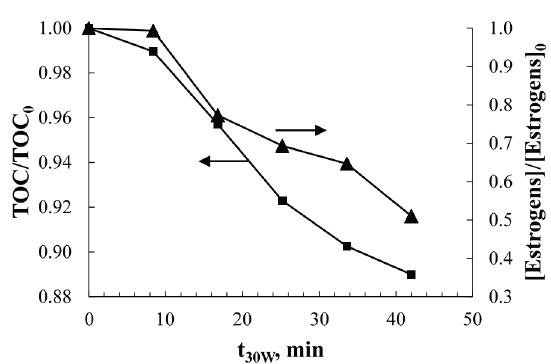
Figure 2. Solar photolytic degradation ( right axis ) and mineralization ( left axis ) of the commercial formulation of E2 and nomegestrol acetate mixture with an initial concentration of 5 ppm of estrogens and 388 ppm of TOC at pH 4.5 and with 97.2 kJ/m 2 of accumulated solar radiation (measured as